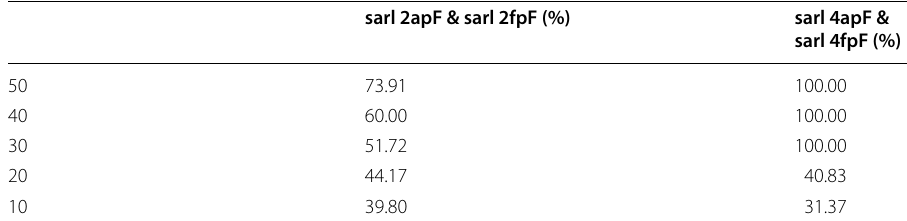
Table 14 Accuracy of the SARL algorithm on the Bible dataset